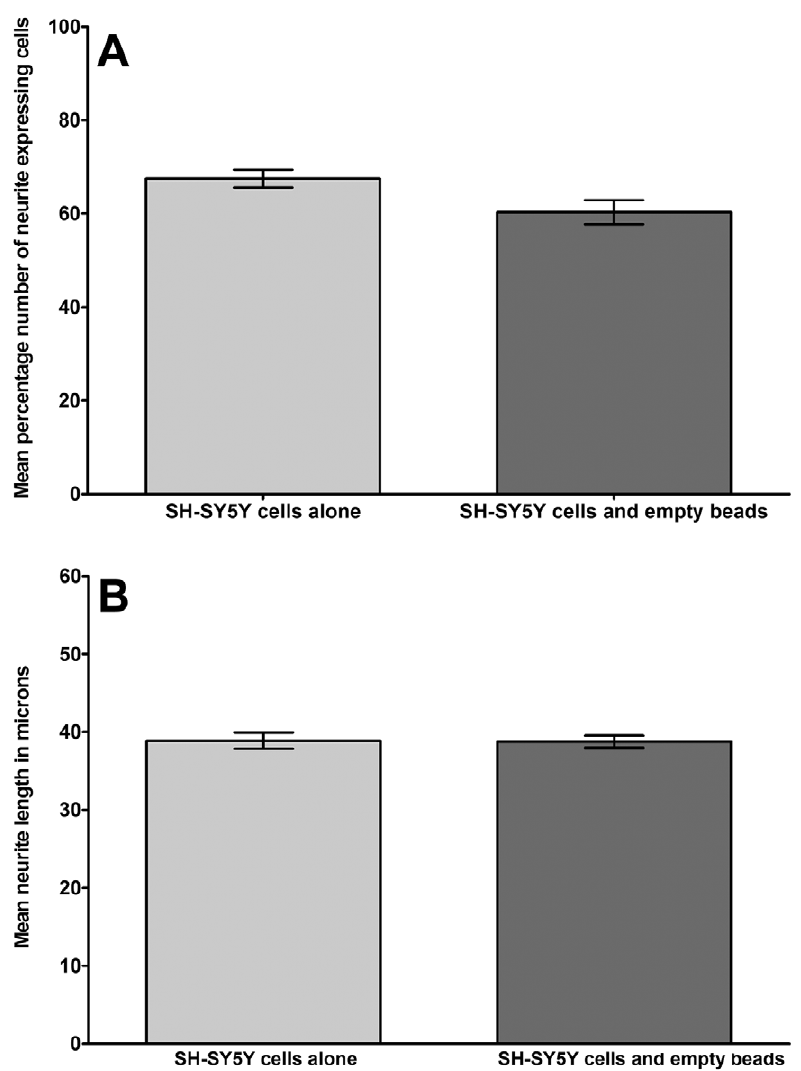
Figure 2. Analysis of neural cell behaviour in control cultures. Histograms to illustrate (A) the percentage number of neurite expressing cells and (B) mean neurite length from differentiated SH-SY5Y cells cultured alone, or co-cultured with empty (cell-free) alginate beads